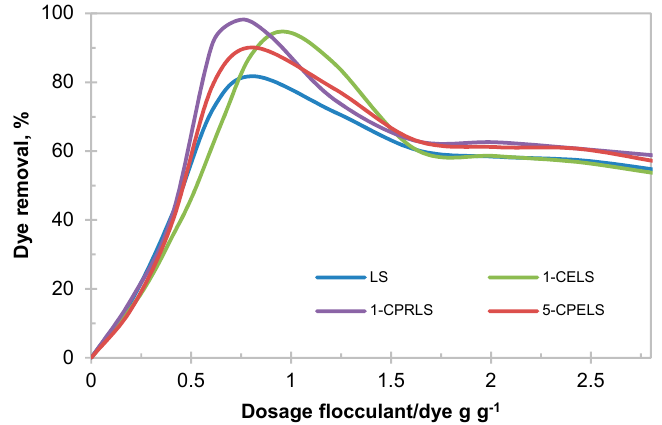
Figure 6. Impacts of dosage of LS, 1-CELS, 1-CPRLS, and 5-CPELS on the removal of ethyl violet (EV) dye from solution.